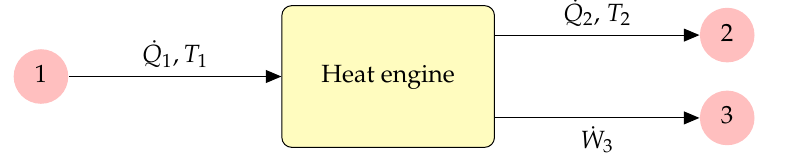
Figure 3. A heat engine that uses heat at 1 to produce heat at 2 and work at 3